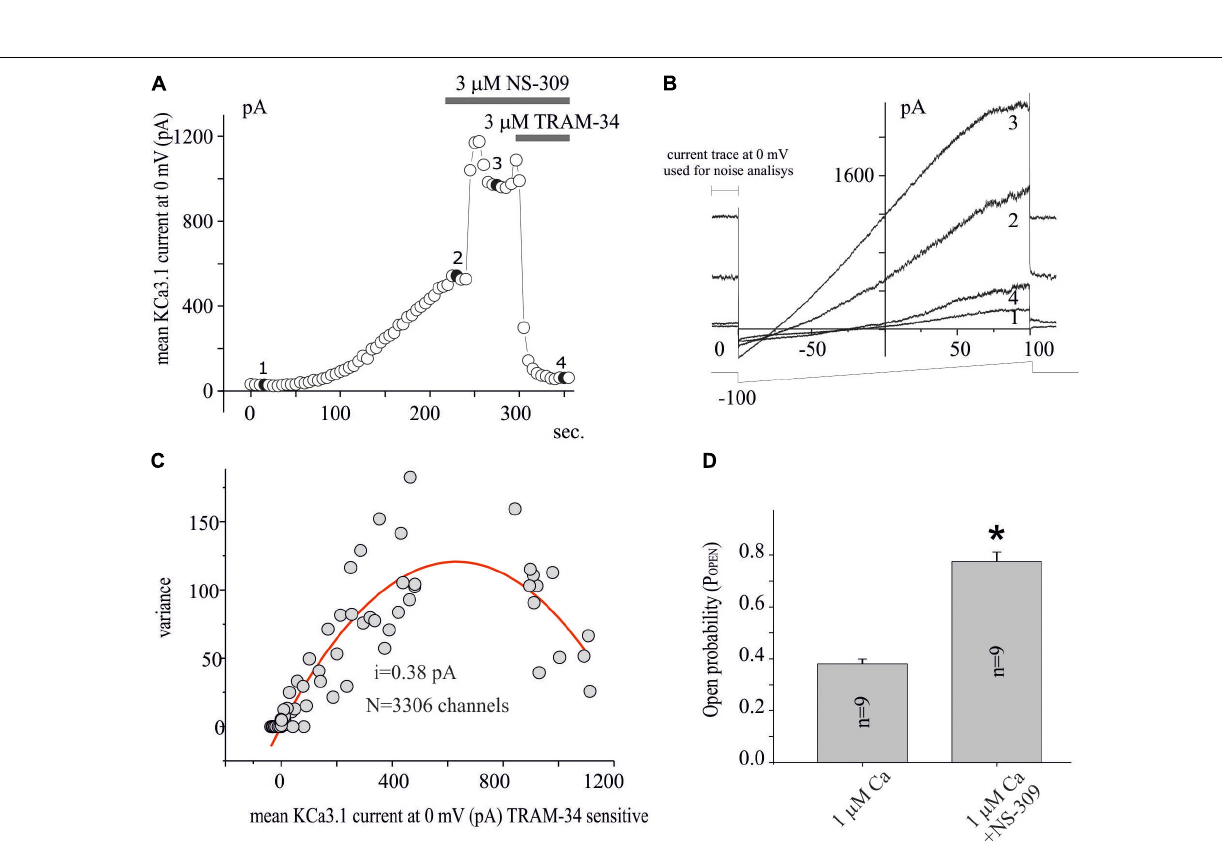
FIGURE 2 | Noise analysis applied to KCa3.1 current in GB. (A) Time course of the current at 0 mV measured by the current ramps obtained by applying linear gradients of potential from –100 to 100 mV (Vh of 0 mV) repeated every 5 s. The times when NS-309 and NS-309 + TRAM-34 are applied, are also shown during recording (gray bars). Whole-cell configuration dialyzed with 1 µ M of free calcium. (B) Current ramps recorded in the times indicated in panel (A) in the conditions CTRL (1), after KCa3.1 current stabilization (2), following 3 µ M NS-309 application (3), and NS-309 + TRAM-34 co-application (4). (C) Plot of the variance ( σ 2 ) against the mean of the current (I) at 0 mV for the recording shown in panel (A) estimated as shown in panel (B) . The red line represents the parabolic fit with the function as reported in the “Materials and methods” section. (D) Bar plot of the P OPEN , estimated as reported in the “Materials and methods” section, with 1 µ M Ca free in the pipette and after extracellular NS-309